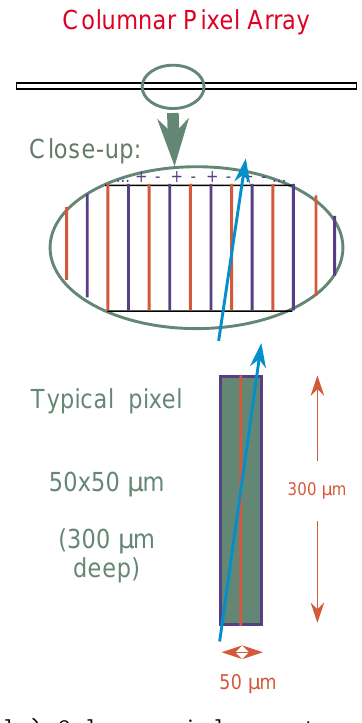
FIG. 72. (Color) Columnar pixel geometry. Courtesy of A. Sill. Fig. 73 the top measurement layer has a finer granular- ity than the bottom confirmation layer. The corresponding rows in the two pixel layers can be read out with different clock speeds to maintain the correct correspondence at the